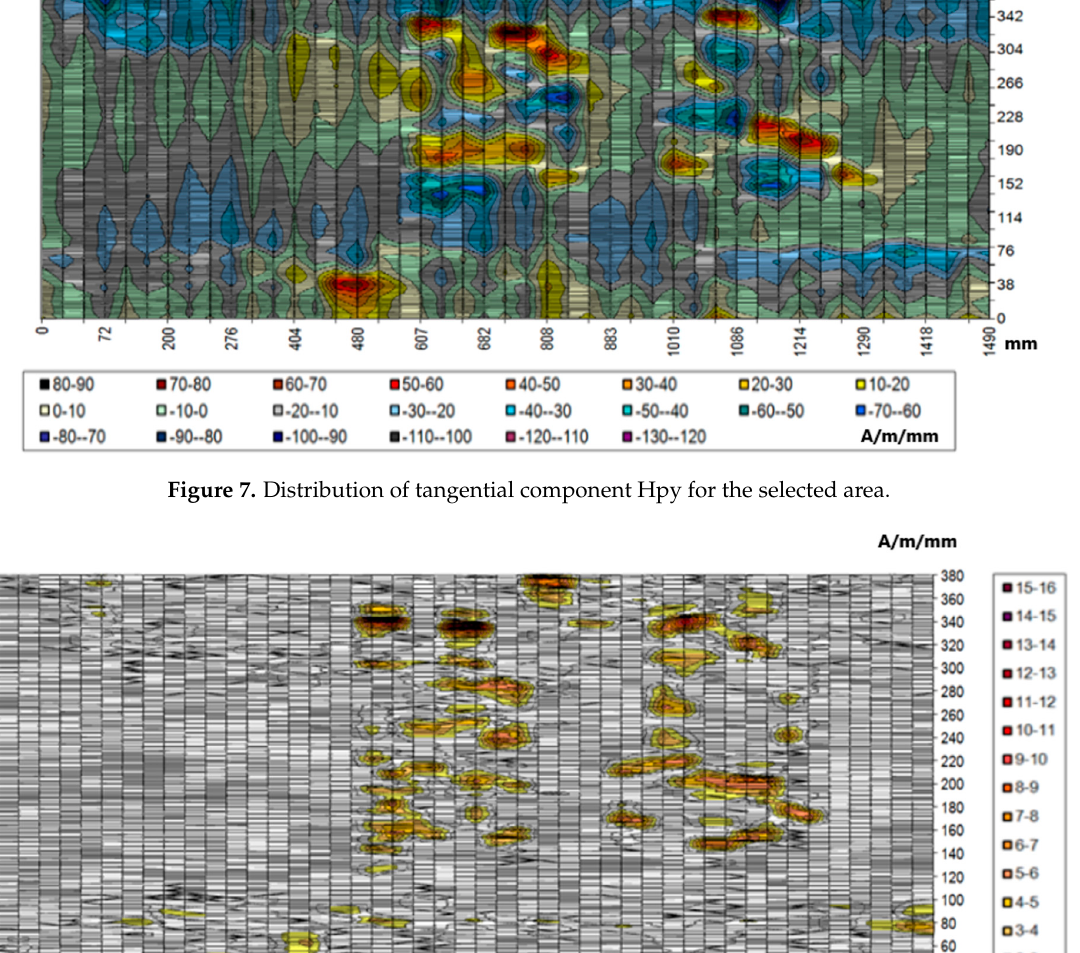
Figure 8. Distribution of the gradient of the tangential component dHpx/dx for the selected area.